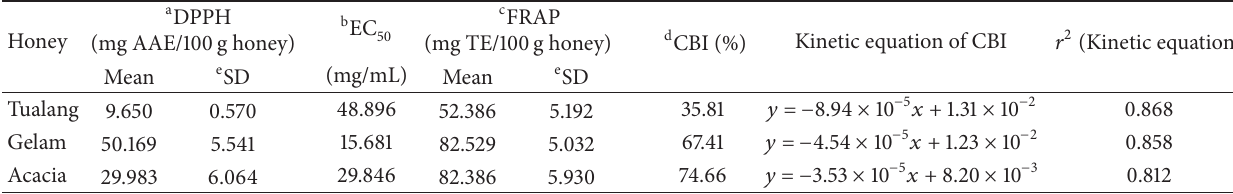
Table 4: Antioxidant activity of honey